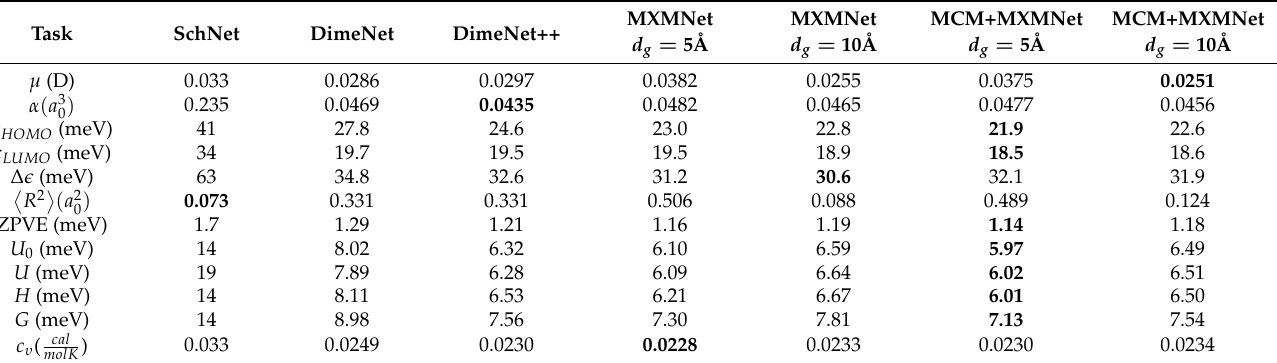
Table 3. Comparison of MAEs of targets on QM9 dataset for different tasks. The best result for each task is in